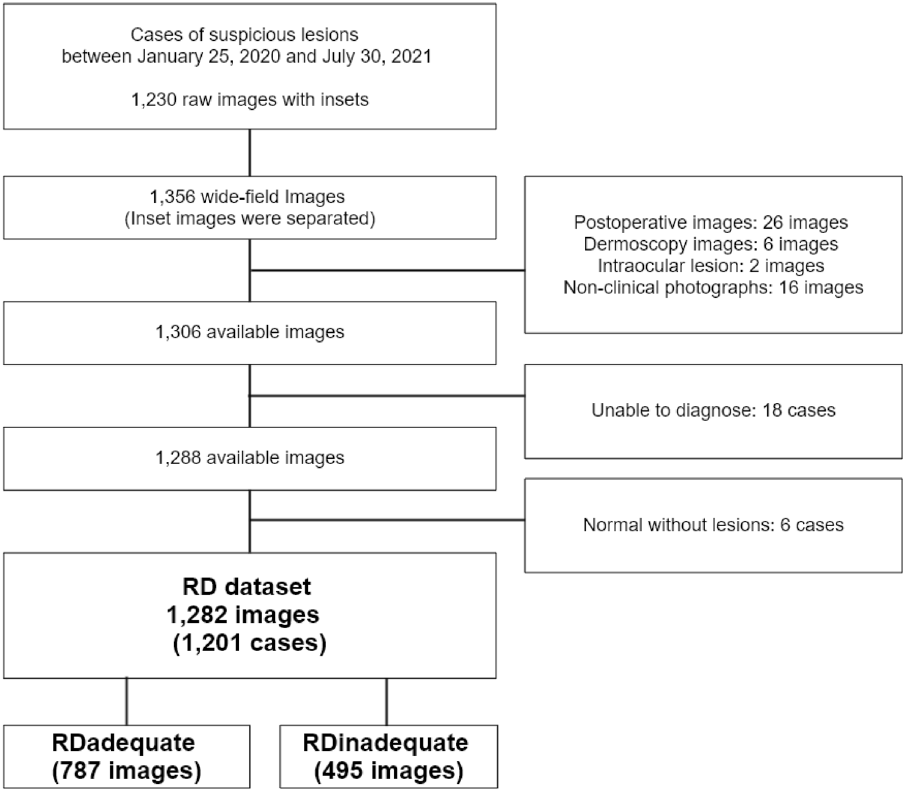
Figure 3. Flowchart of the RD